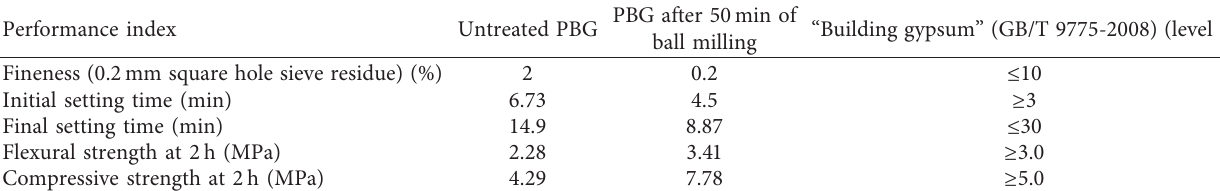
Table 4: Comparison of ball milling PBG with national standards.